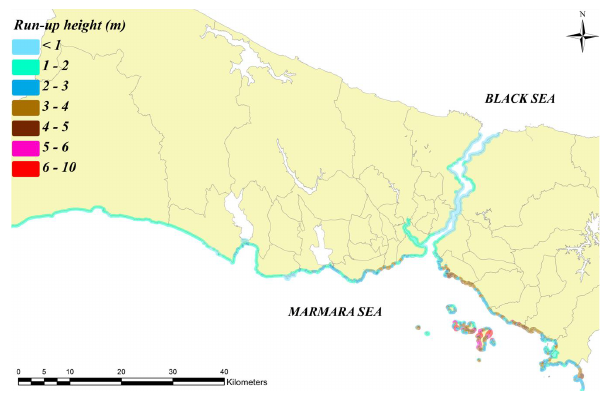
1 Figure 4. Maximum inundation depths resulting from the probabilistic simulations for 10% probability of exceedance in 50 years.